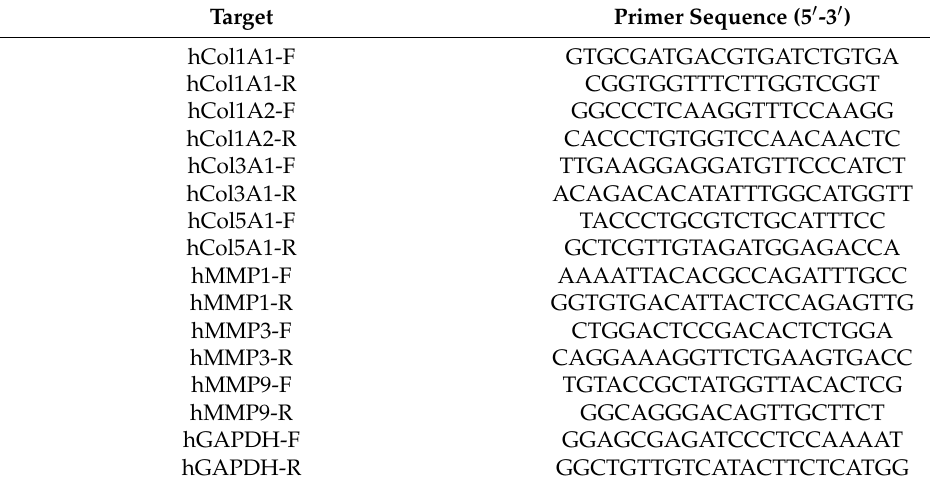
Table 2. The primer sequences in qRT-PCR